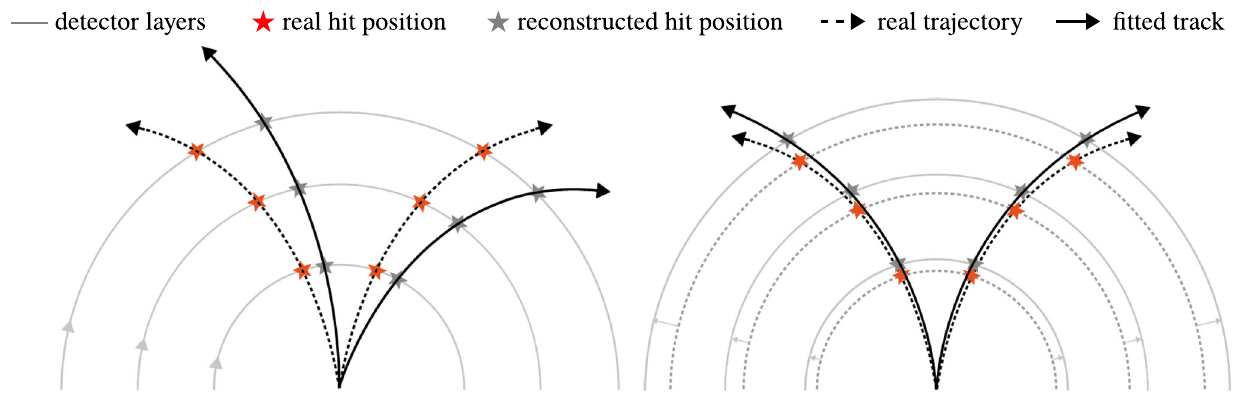
the detector layers depending linearly on the radius. The real (dashed black line) and fitted (solid black line) particle trajectories are shown. Red stars indicate real measurement positions and grey stars show the reconstructed hit positions (biased measurements)